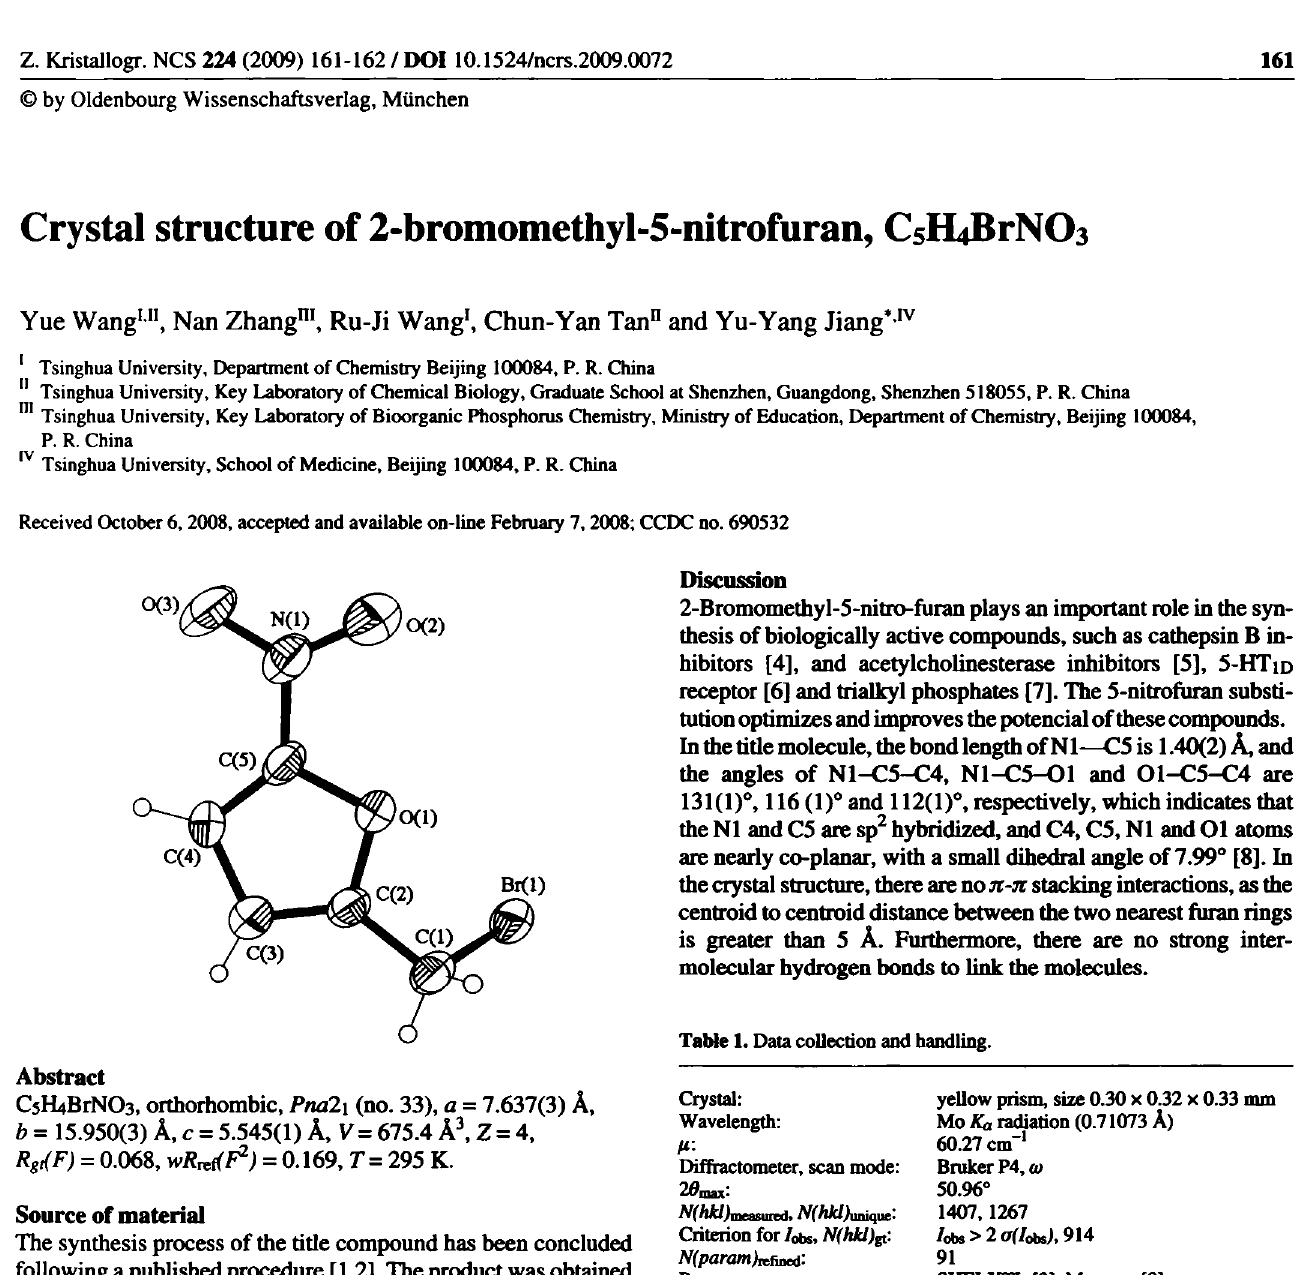
Table 2. Atomic coordinates and displacement parameters (in Â 2 ).